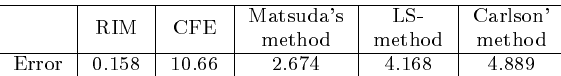
where ∆ h 1 R ‘ (t) - error of time response by RIM method; ∆ h 1 cfe (t) - error of time response by CFE method; ∆ h 1 mat (t) - error of time response by Matsuda’s method; ∆ h 1 ls (t) (cid:21) error of time response Least-squares method; ∆ h 1 car (t) - er- ror of time response by Carlson’s